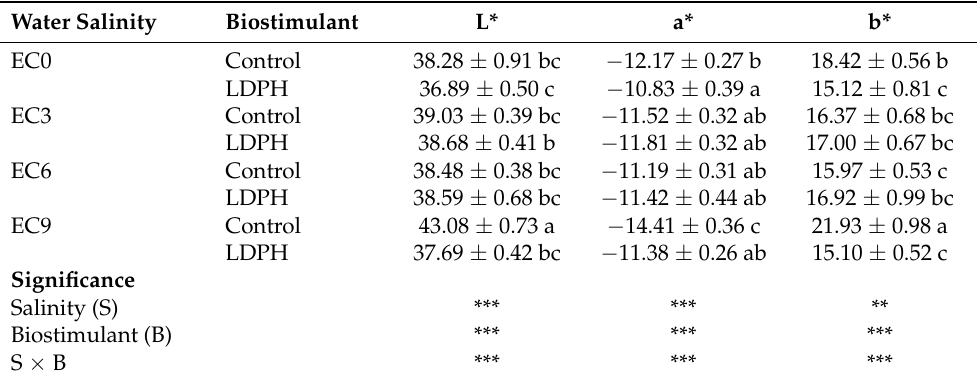
Table 3. Effects of irrigation water salinity and biostimulant applications on leaf color parameters of spinach